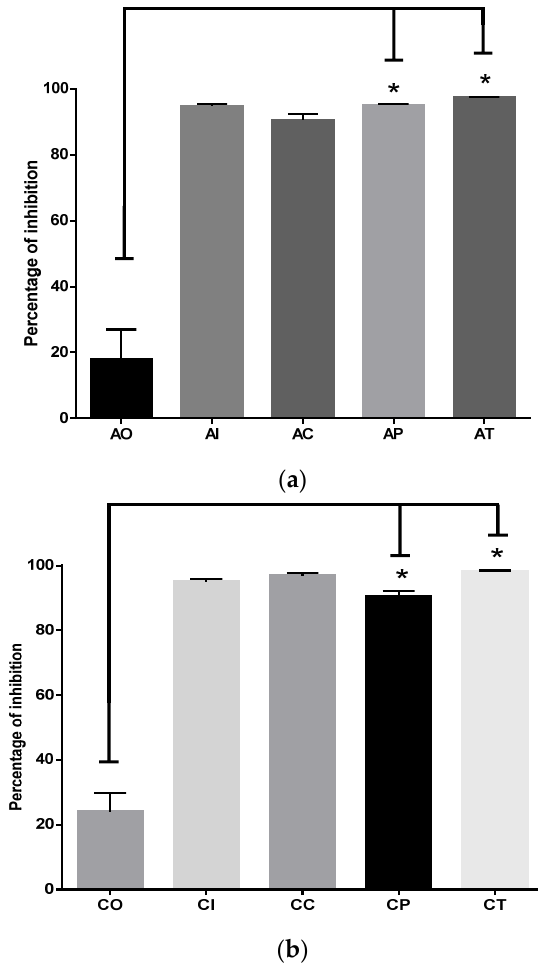
Figure 4. Inhibition of oxidative damage to lipids by curcumin in acute and chronic phases after exposure to ozone: ( a ) in the acute exposure to ozone, the administration of dietary curcumin in preventive and therapeutic modes significantly inhibited the oxidative damage to lipids (* p < 0.01) compared to the control group exposed to ozone OA; acute O 3 (AO), acute intact (AI), acute CUR (AC), acute preventive (AP), acute therapeutic (AT); ( b ) the effect of curcumin in preventive and therapeutic administration significantly inhibited oxidative damage to lipids (* p < 0.01), compared to the CO group; chronic O 3 (CO), chronic intact (CI), chronic CUR (CC), chronic preventive (CP), chronic therapeutic (CT).